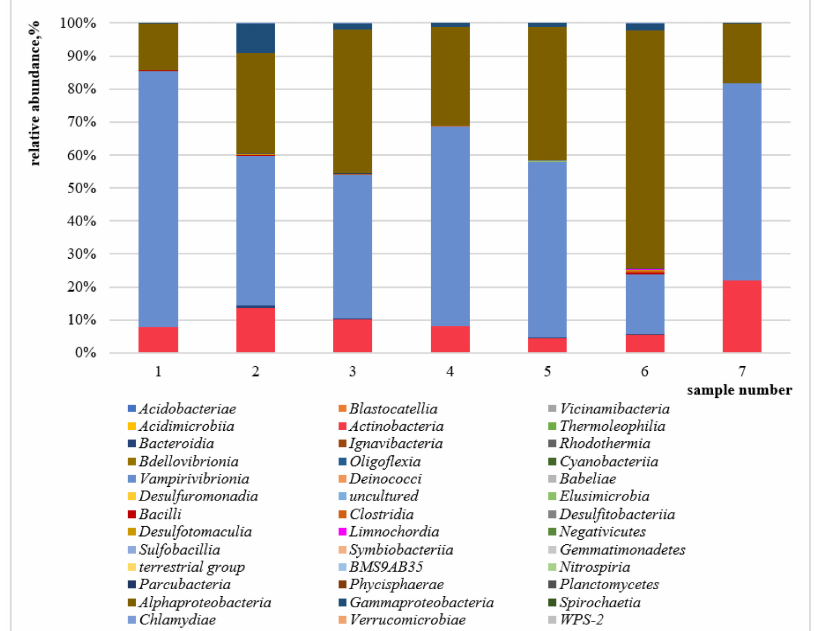
Figure 5. Bacterial communities in all samples at the class